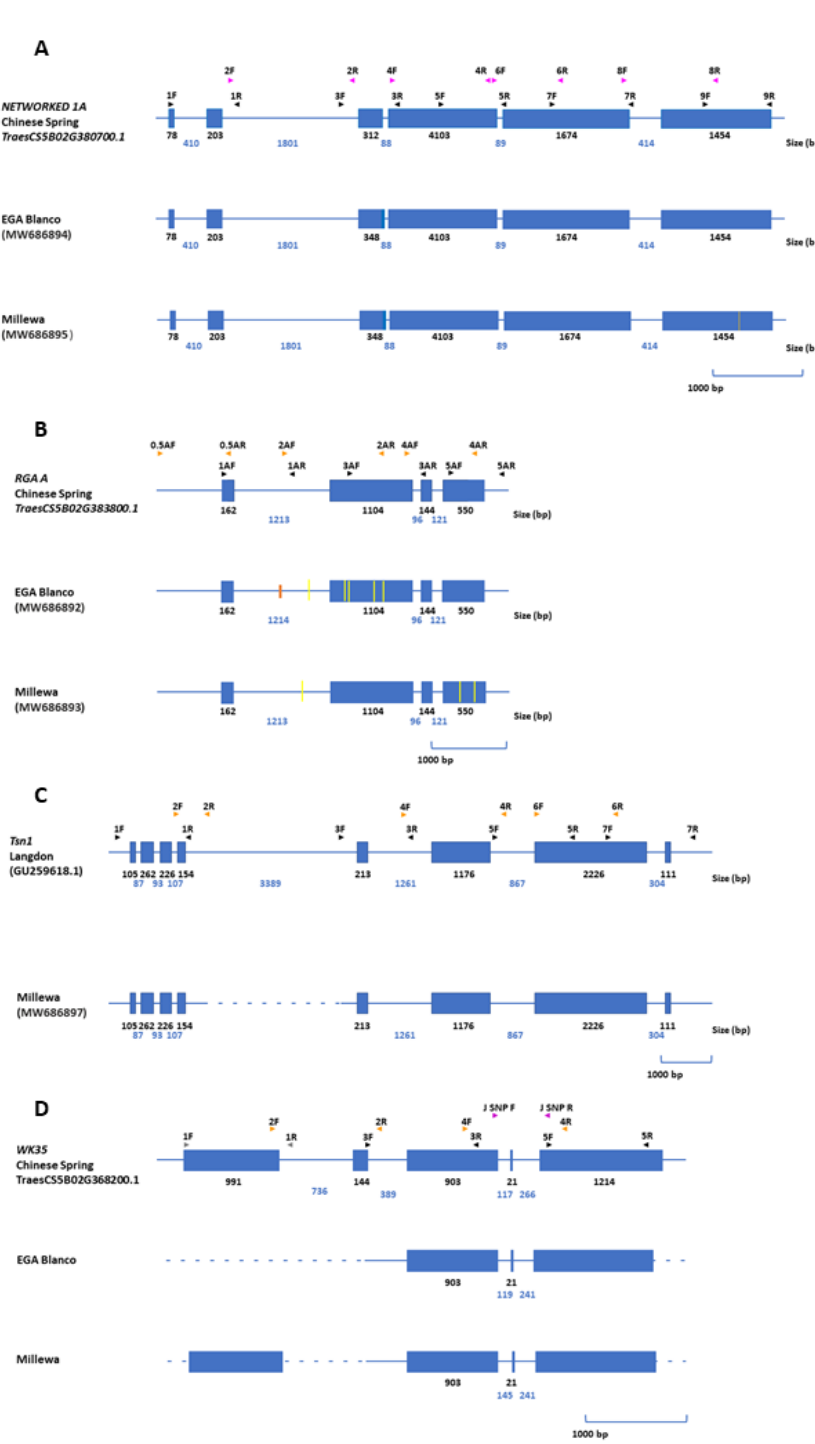
Figure 4. Gene structure for ( A ) NETWORKED 1A , ( B ) RGA A, ( C ) Tsn1 and ( D ) Wk35 on chromosome 5BL from reference sequence and varieties. Blue lines and boxes represent introns and exons, respectively, for annotated genes from reference sequences. Position of PCR primers for amplifying tiling paths from varieties are shown above gene structure from the reference sequences. Size of introns and exons are shown in base pairs (bp). Dashed blue lines represent regions where tiling paths were unable to be amplified in corresponding varieties. Yellow and orange lines represent SNP and INDELS, respectively, between reference sequences and varieties. Genbank accession numbers for complete annotated genes are provided in